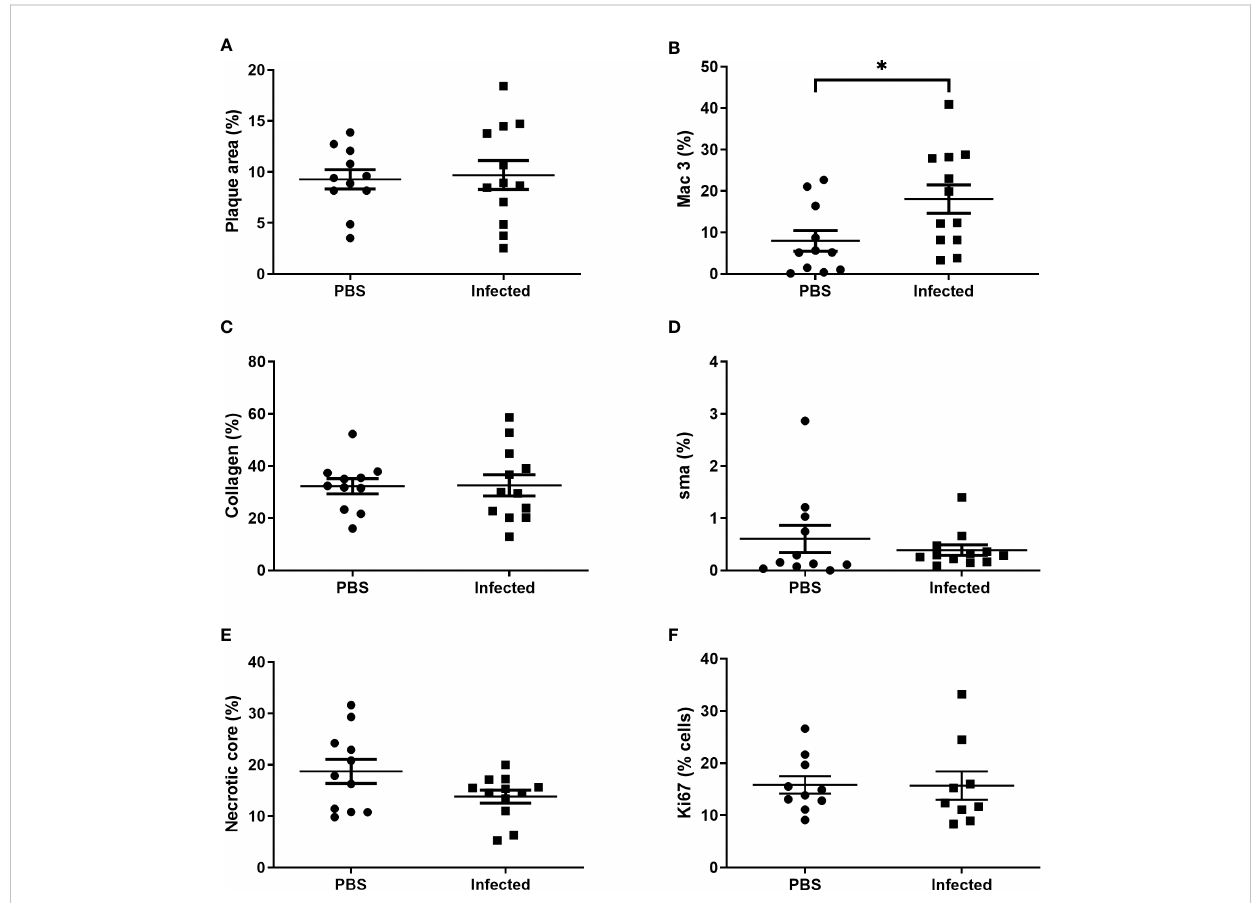
FIGURE 4 Pneumococcal pneumonia results in increased atherosclerotic plaque macrophage content 2 weeks post pneumonia but no effect on other markers of plaque vulnerability. Male ApoE -/- mice aged 11-12 weeks were fed a Western diet for 8 weeks prior to intranasal instillation of 5x10 5 cfu serotype 4 (TIGR4) S. pneumoniae or mock infection with PBS. Mice received three doses of s.c. 100 mg/kg amoxicillin 12 hourly commenced 24 h after infection/mock infection and were maintained on chow diet post infection. Aortic sinus lesion area (A) , expressed as a % of sinus CSA, in control mice and S. pneumoniae infected mice. Plaque macrophage (B) , collagen (C) and smooth muscle actin (D) content expressed as % area of positive staining/total lesion area. Plaque necrotic core area expressed as % of total plaque area (E) . Plaque cell replication (F) expressed as % of plaque cells staining positive for Ki67. Data were analysed using unpaired t test (A – C, E, F) or Mann-Whitney U test (D) (n=11-12,